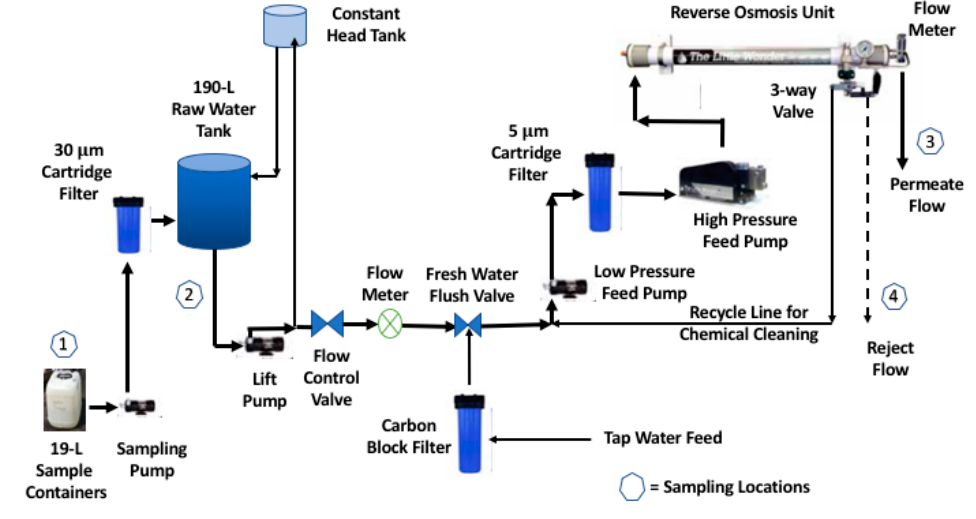
Figure 1. Process flow diagram and sampling locations. Table 1. Sampling and Analysis Plan 1 .